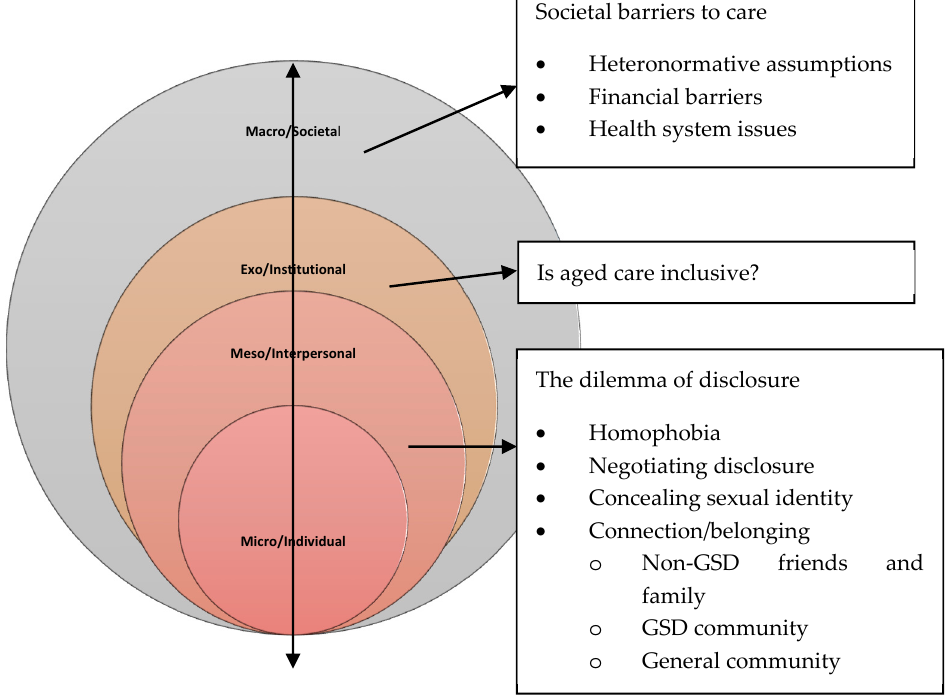
Figure 2. A socio-ecological analysis of the experiences of gender and sexually diverse (GSD) women accessing health, social and aged care services .